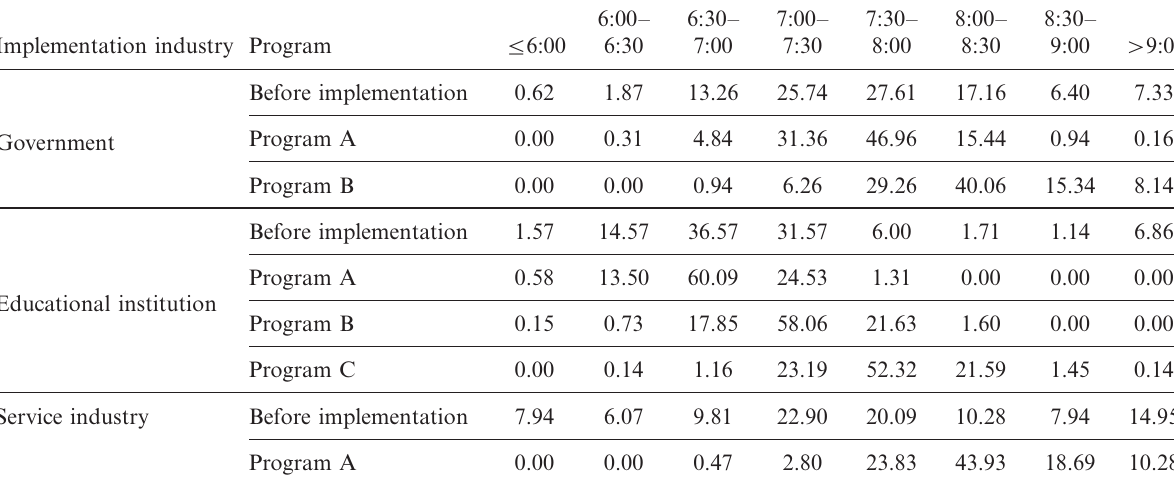
Table 8. Commute time distribution after implementation of the programs for each industry Implementation industry Program